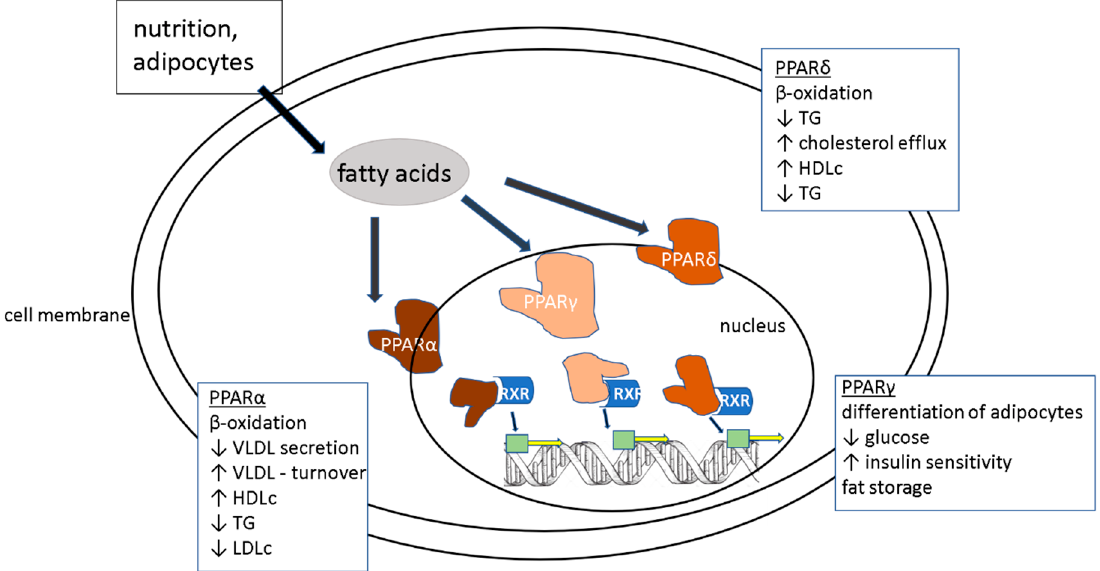
Figure 2. Simple illustration of the functions and effects of the different peroxisome proliferator-activated receptor (PPAR) subtypes. Through nutrition and from adipose tissue, fatty acids are being taking into cells. There they activate the different subtypes of PPARs, which then enter the nucleus and connect with retinoid X receptor (RXR) receptors. Binding of both leads to the inductions of transcription of several different genes involved and needed in lipid and cholesterol metabolism (not shown in detail). Abbreviations: High-, low, and very low- density lipoprotein (HDL, LDL, VLDL), Trigycerides (TG)